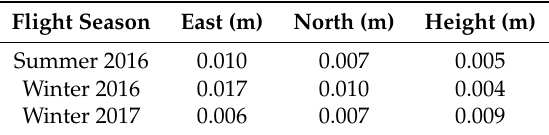
Table 2. Root Mean Square Error between the measured and estimated coordinates of Ground Control Points (GCPs).